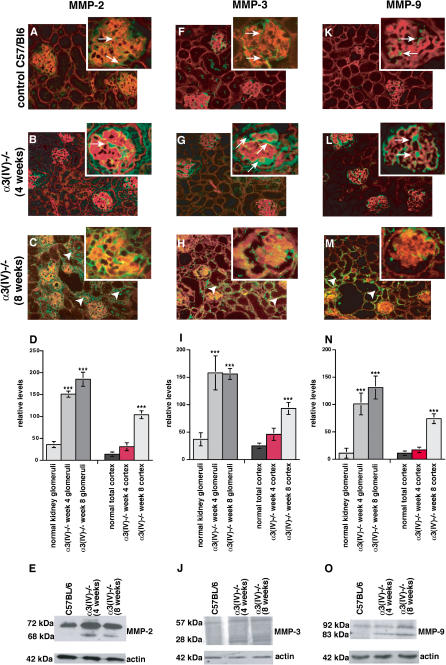
MMP Expression in Kidneys of
α3(IV)
−/− Mutant and Wild-Type Mice
Frozen sections of control C57/Bl6 mice and
α3(IV)
−/− mice were stained with primary antibodies for MMP-2, MMP-3, and MMP-9 (FITC-green), and sections were counterstained with Rhodamine-labeled antibodies for entactin (red).
(A) In control C57/Bl6 mice, MMP-2 is present sporadically in the glomeruli and in some proximal tubules (arrows).(B) After 4 wk of age, MMP-2 is increased in the glomeruli (arrows) in
α3(IV)
−/− mice compared to age-matched control kidneys, even before manifestation of proteinuria.
(C) After 8 wk of age (after manifestation of GBM-splitting and initiation of interstitial fibrosis), MMP-2 is increased in the interstitium (arrowheads) and in the glomeruli (arrows) in kidneys from
α3(IV)
−/− mice.
(D) MMP-2–staining was quantified using NIH ImageJ software in the glomeruli (left panels) and in total kidney cortex. Glomerular MMP-2–staining was significantly increased at 4 wk in
α3(IV)
−/− as compared with control. ***
p < 0.001 versus control.
(E) MMP-2 expression was analyzed by immunoblot using total protein from the kidney cortex of single mice. A representative blot is shown, confirming increased expression of MMP-2 in
α3(IV)
−/
−. The lower blot displays the control blot for actin to confirm equal loading.
(F) Immunofluorescence staining revealed that MMP-3–staining is present in the glomeruli (arrows) of control C57/Bl6 mice.(G) MMP-3 is significantly increased in the glomeruli of
α3(IV)
−/− mice after 4 wk of age.
(H) In 8-wk-old
α3(IV)
−/− mice, MMP-3 is up-regulated in the interstitium (arrowheads) and MMP-3 is also present in the glomeruli (arrows).
(I) Quantification of MMP-3–staining revealed a significant increase of MMP-3–staining in the glomeruli and total cortex of
α3(IV)
−/− mice at 4 wk and 8 wk of age. ***
p < 0.001 versus control.
(J) Immunoblot analysis revealed increased renal MMP-3 protein.(K) MMP-9 is present in the glomeruli of C57/Bl6 control mice (arrows).(L) The onset of proteinuria is preceded by a significant increase of MMP-9 in the glomeruli of
α3(IV)
−/− mice (arrows).
(M) MMP-9 is significantly up-regulated in the interstitium (arrowheads) and in the glomeruli (arrows) of 8-wk-old
α3(IV)
−/− mice compared to control.
(N) Quantification of immunofluorescence staining using ImageJ software confirmed a significant increase of MMP-9 expression in the glomeruli (left panels) and total cortex region (right panels) of
α3(IV)
−/−mice as compared with control. ***
p < 0.001 versus control.
(O) Increased MMP-9 expression was confirmed by immunoblot.